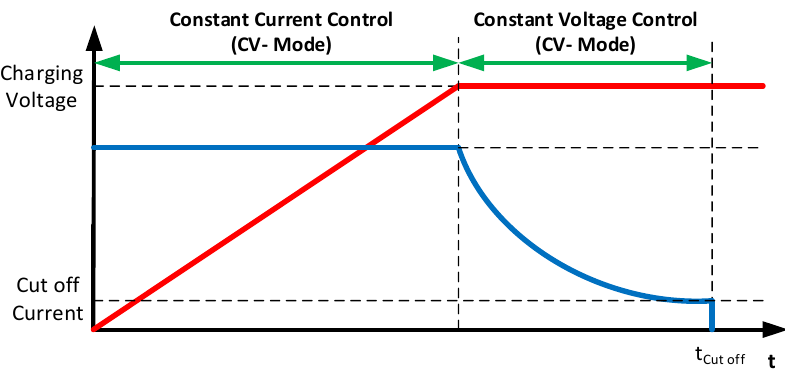
Figure 5. Charging algorithm constant current (CC-Mode) / constant voltage (CV-Mode) [36].